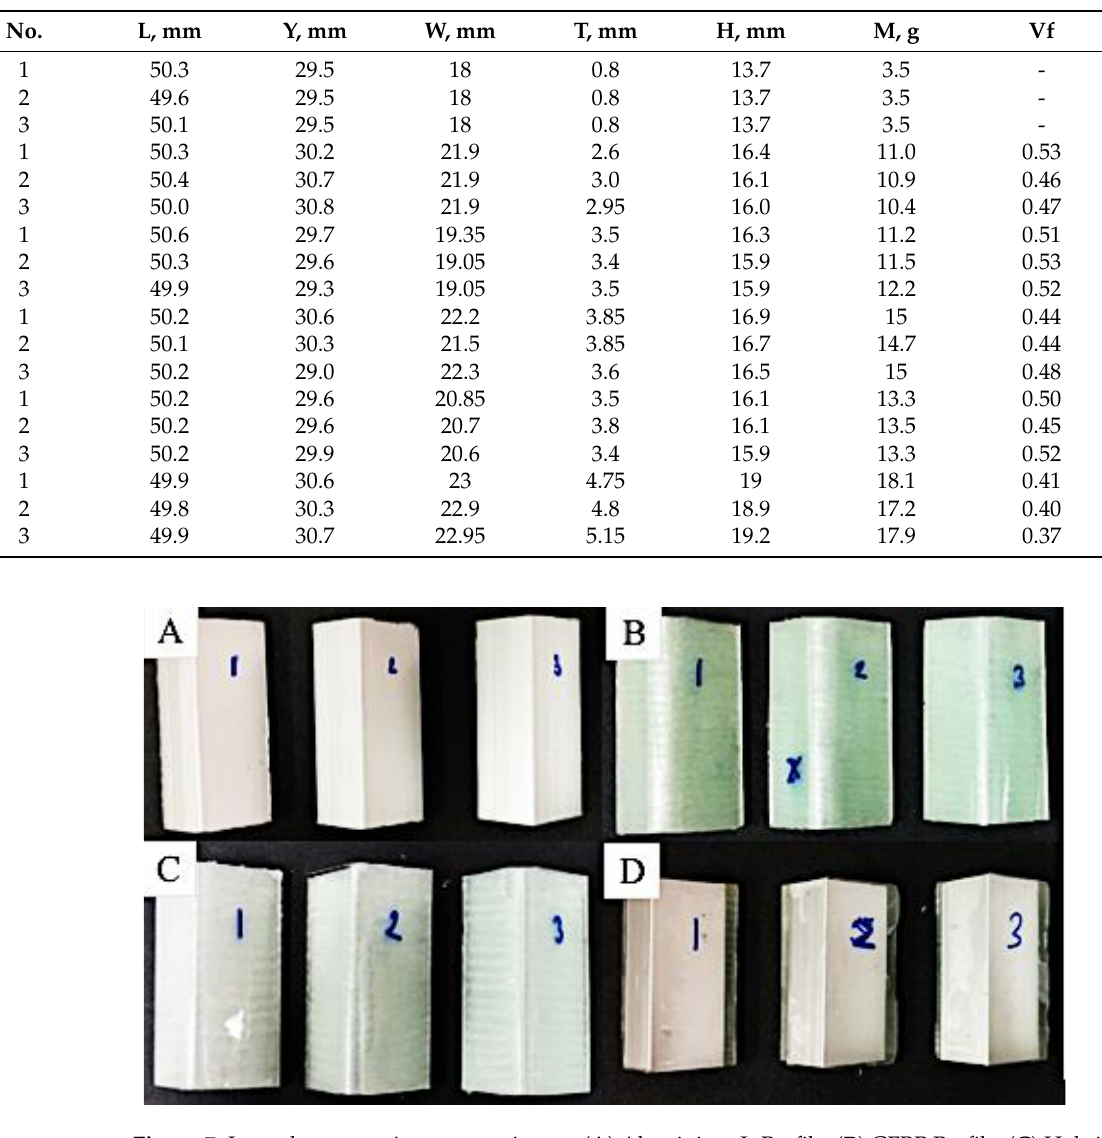
Figure 7. Lateral compression test specimens. ( A ) Aluminium L-Profile; ( B ) GFRP Profile; ( C ) Hybrid laminates with GFRP attached on the outer surface of L-Profile; ( D ) Hybrid laminates with GFRP attached on the inner surface of L-Profile.